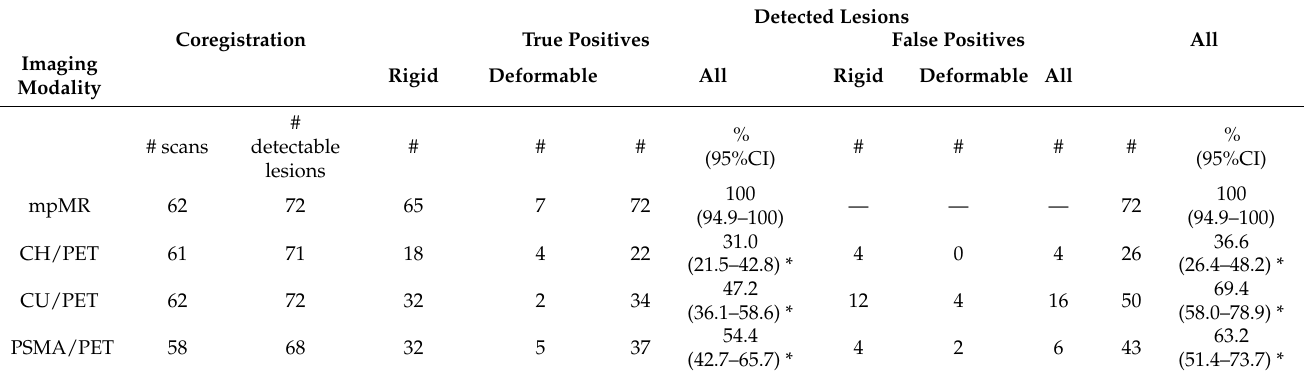
Table 3. Lesions detected within the prostatic fossa by imaging